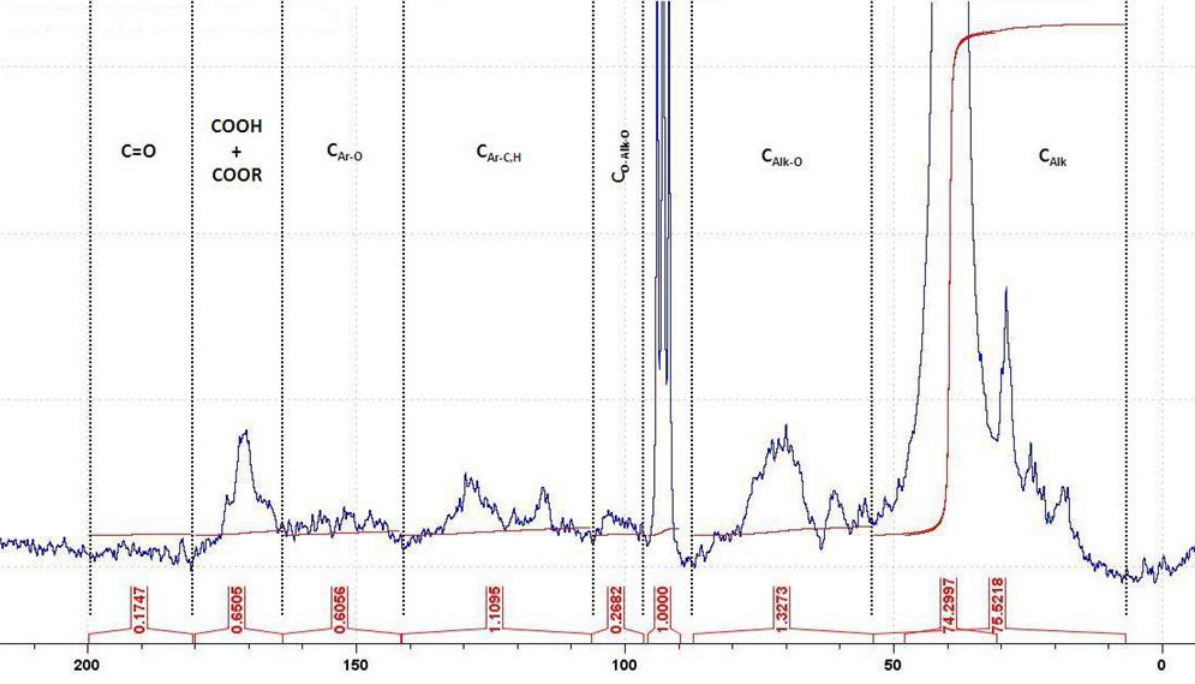
Figure A1. 13 C-NMR spectrum of humic acids in DMSO.